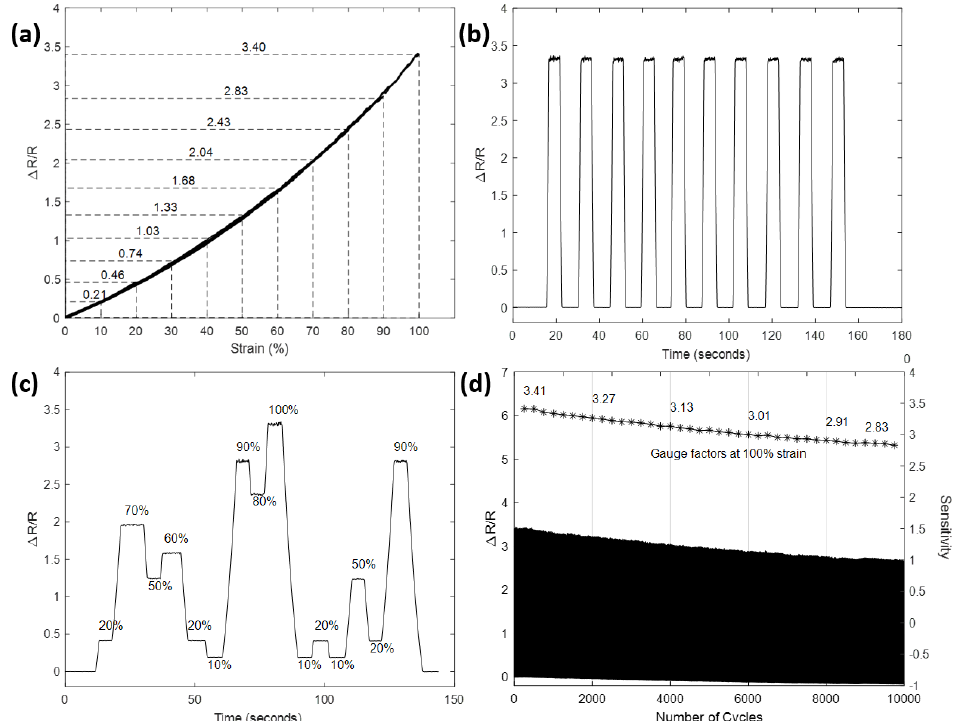
Figure 5. Evaluation of strain-sensing performance. ( a ): Signals corresponding to multiple stress- release cycles of different applied strain demonstrating negligible hysteresis. ( b ): Signals corre- sponding to ten rapid stretch-hold-release cycles of 100% peak strain demonstrating negligible overshoot. ( c ): Signals in response to dynamically applied strain. ( d ): Relative change in resistance and corresponding gauge factors over 10,000 stretch-release cycles